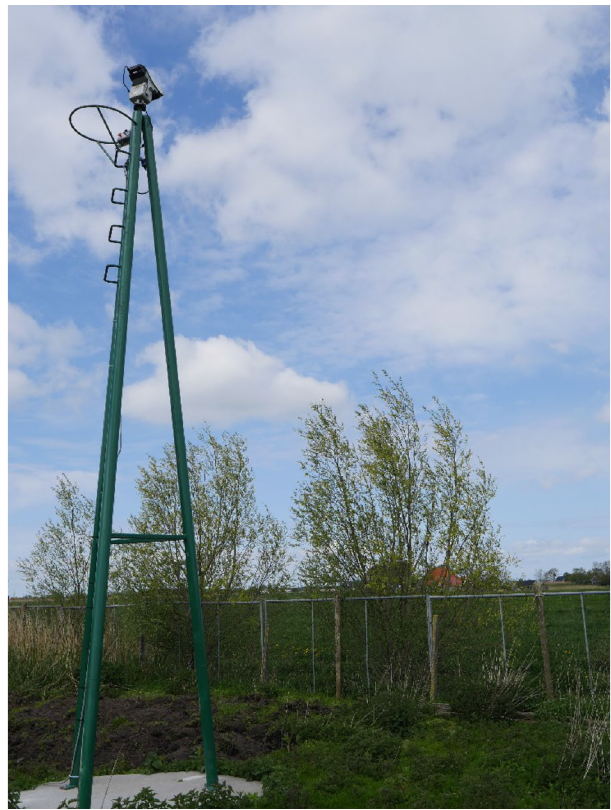
Figure 3. The laser placed on a steel, three-legged tower (the top was 6 m above ground level) that was secured to a concrete slab (1.5 m × 1.5 m) weighing approximately 2000 kg (source: photo by first